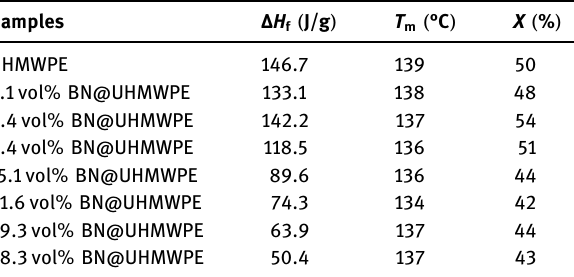
Table 1: DSC results for the UHMWPE and BN@UHMWPE composites